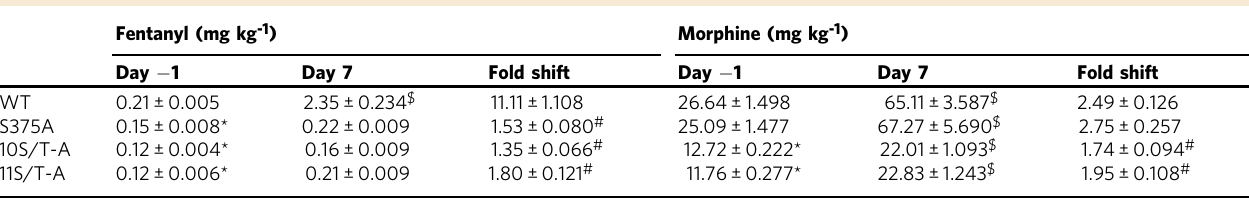
Summaryof pED 50 values(mg kg − 1 ) forhot-plate cumulativeanalgesicdose-response curvesbefore(day – 1)and after(day 7)chronictreatment withosmoticpumpsdelivering fentanyl(2mg/kg/day) or morphine (17mg/kg/day) ( n = 9 – 12). Data are the means±s.e.m. * indicates statistically signi fi cant differences in the comparison of pED 50 values on day − 1 to those values in WT (for fentanyl: F (3, 44) = 56.47, P <0.0001; for morphine: F (3, 39) = 52.16, P <0.0001) $ indicates statistically signi fi cant differences in the comparison of pED 50 values between days − 1 and 7 (fentanyl: F (7, 88) = 86.14, P <0.0001; morphine: F (7, 78) = 75.56, P <0.0001) # indicates statistically signi fi cant differences in the comparison of the fold shift to that in WT (fentanyl: F (3, 44) = 72.97, P <0.0001; morphine: F (3, 39) = 9.103, P = 0.0001). One-way ANOVA with Bonferroni post hoc